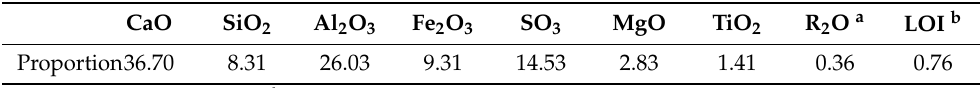
Table 4. Chemical composition of binder materials (wt.